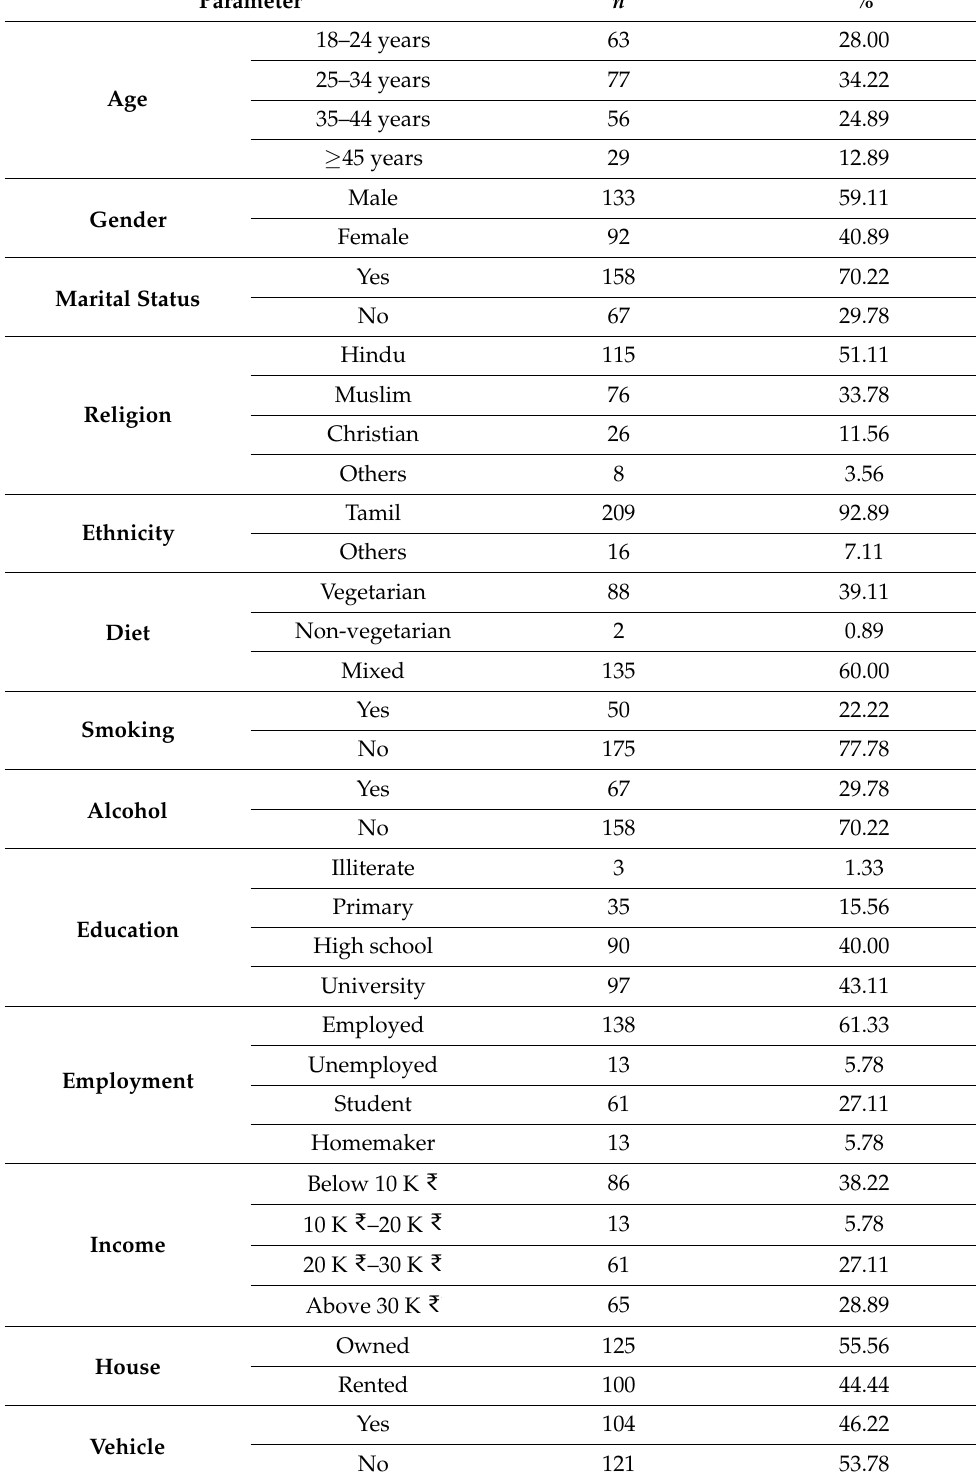
Table 2. Socio-Demographic Characteristics of Study Population ( n = 225).